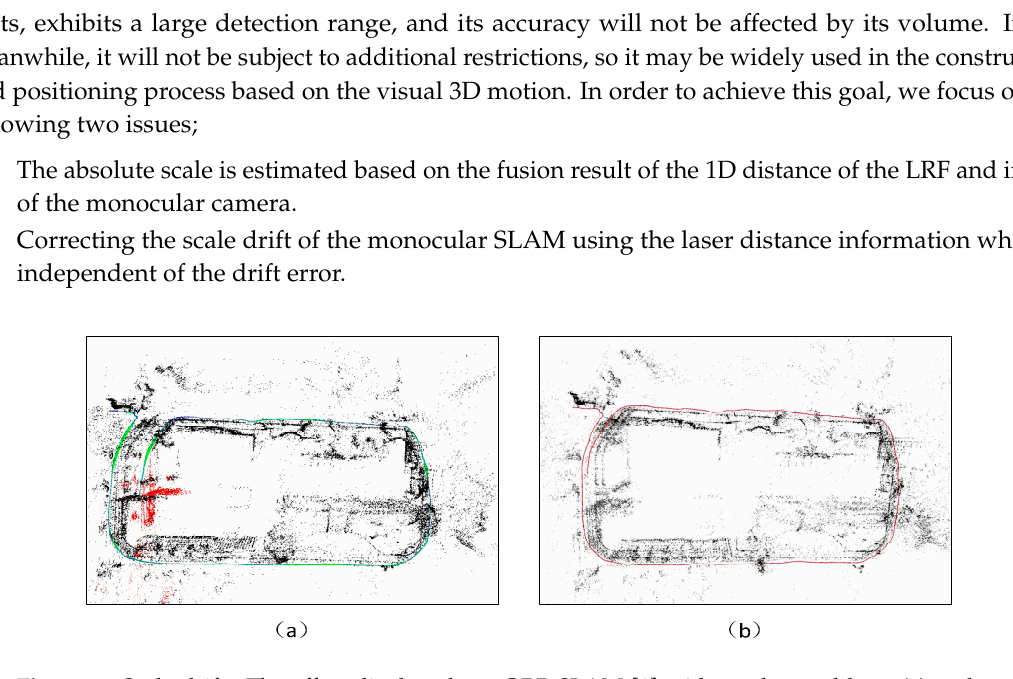
Figure 1. Scale drift. The effect display about ORB-SLAM [1] without detected-loop ( a ) and our proposed fusion LRF and monocular SLAM ( b ). The end of the trajectory should coincide with the starting position.